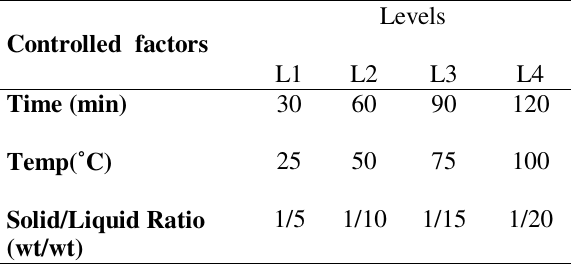
Three controlled factors and their levels are used in leaching process of the catalytic powder by aqua regia